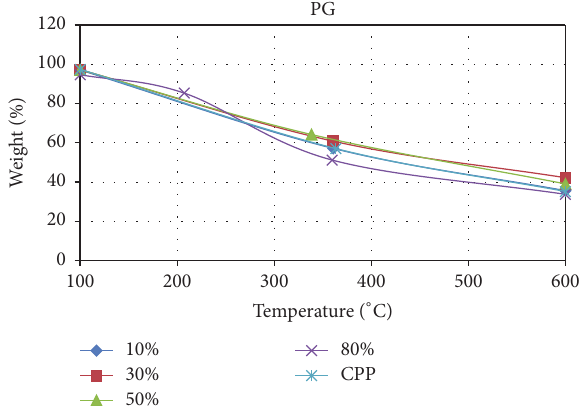
Figure 7: Thermal conductivity values for all PUF samples (PUF with commercial polyether polyol: 0,030 W/m ⋅ K).